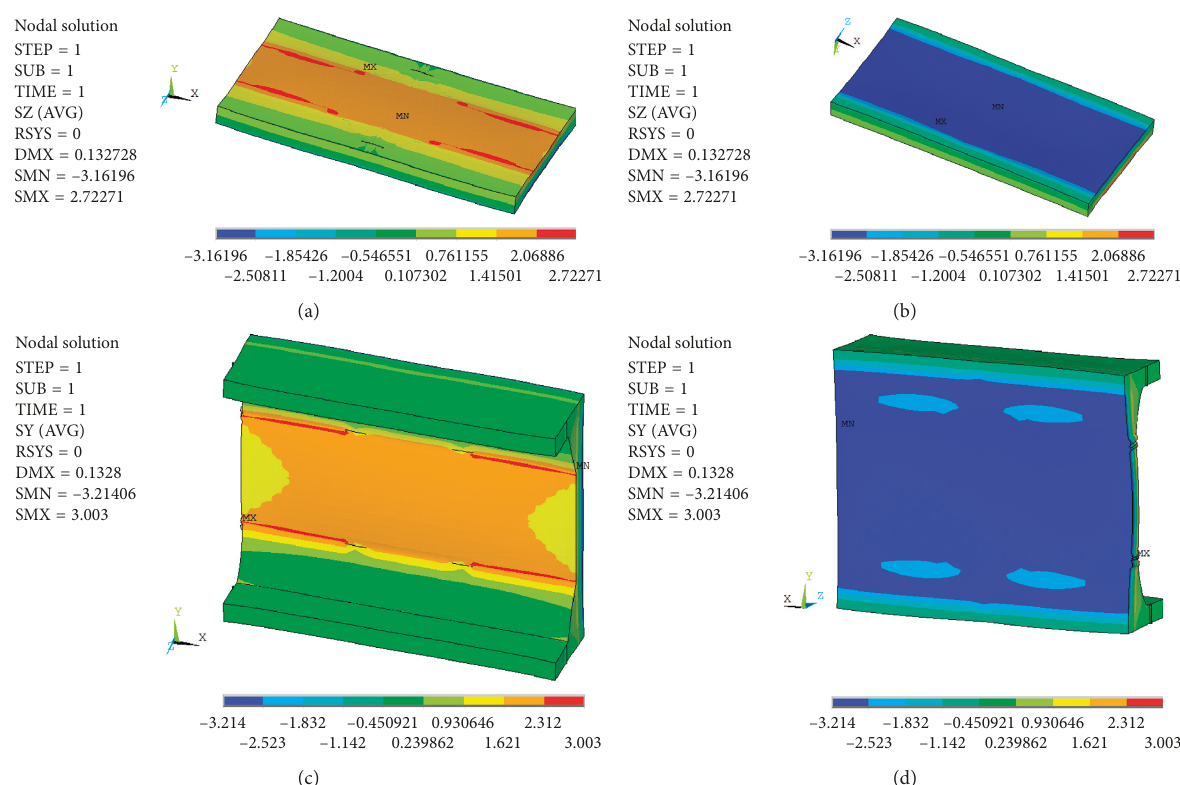
Figure 12: Stress distribution in bottom of the slab and web of the arch rib when the temperature gradient rises 10 ° C. Normal stress distribution on (a) the inner surface of the bottom slab; (b) the outer surface of the bottom slab; (c) the inner surface of the web; (d) the outer surface of the web.